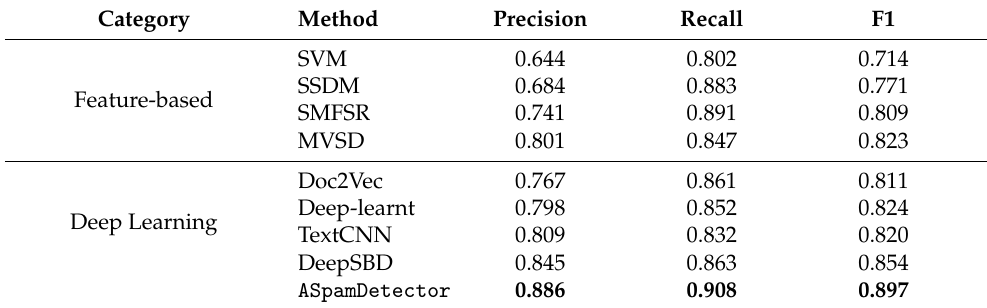
Table 3. Performance evaluation on the Twitter dataset. We report the average scores under five runs. Category Method Precision Recall